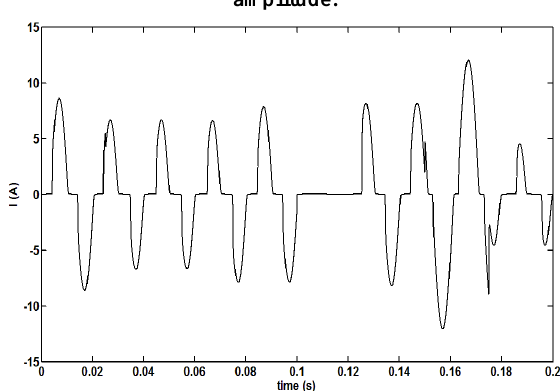
Figure 6. A typical current of HIF with constant amplitude.